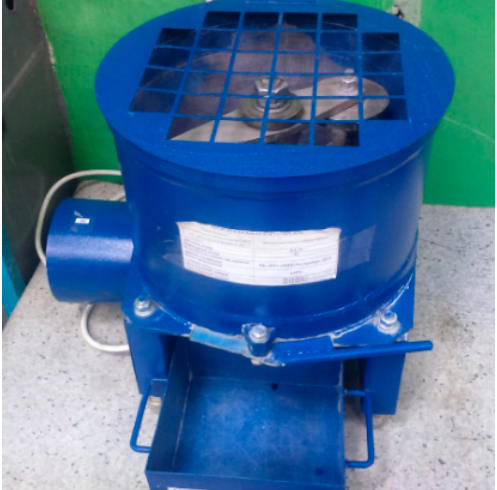
Figure 5. Laboratory concrete mixer BL-10.